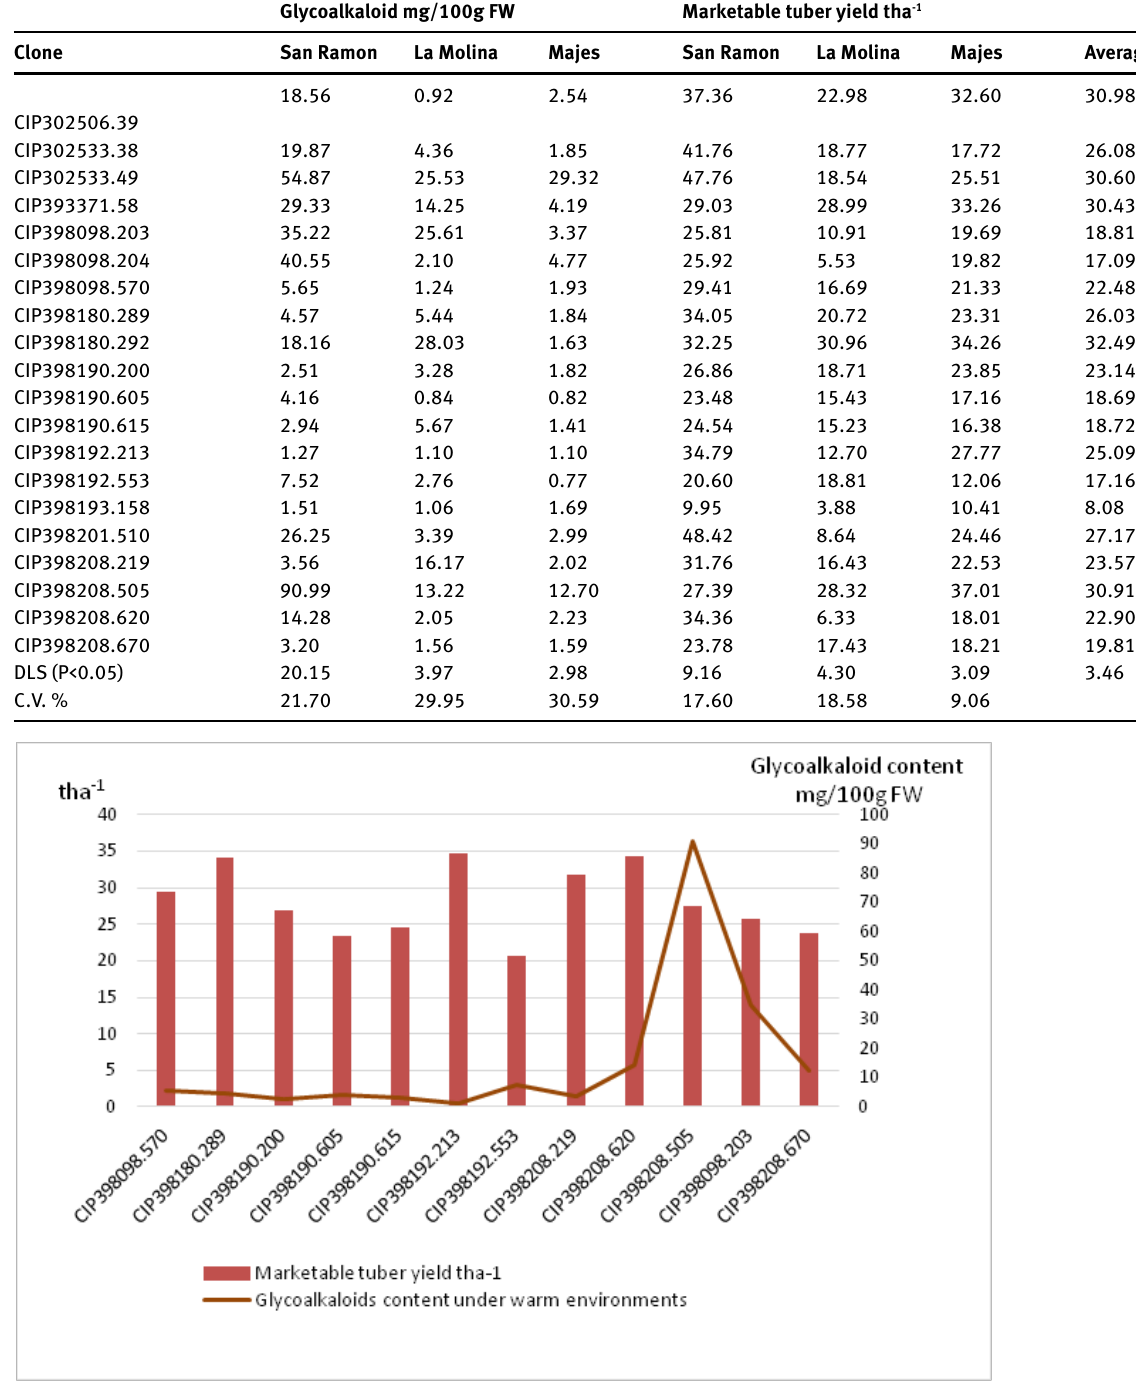
Figure 5: Marketable tuber yield in ten clones with low glycoalkaloid content under warm environment. San Ramon